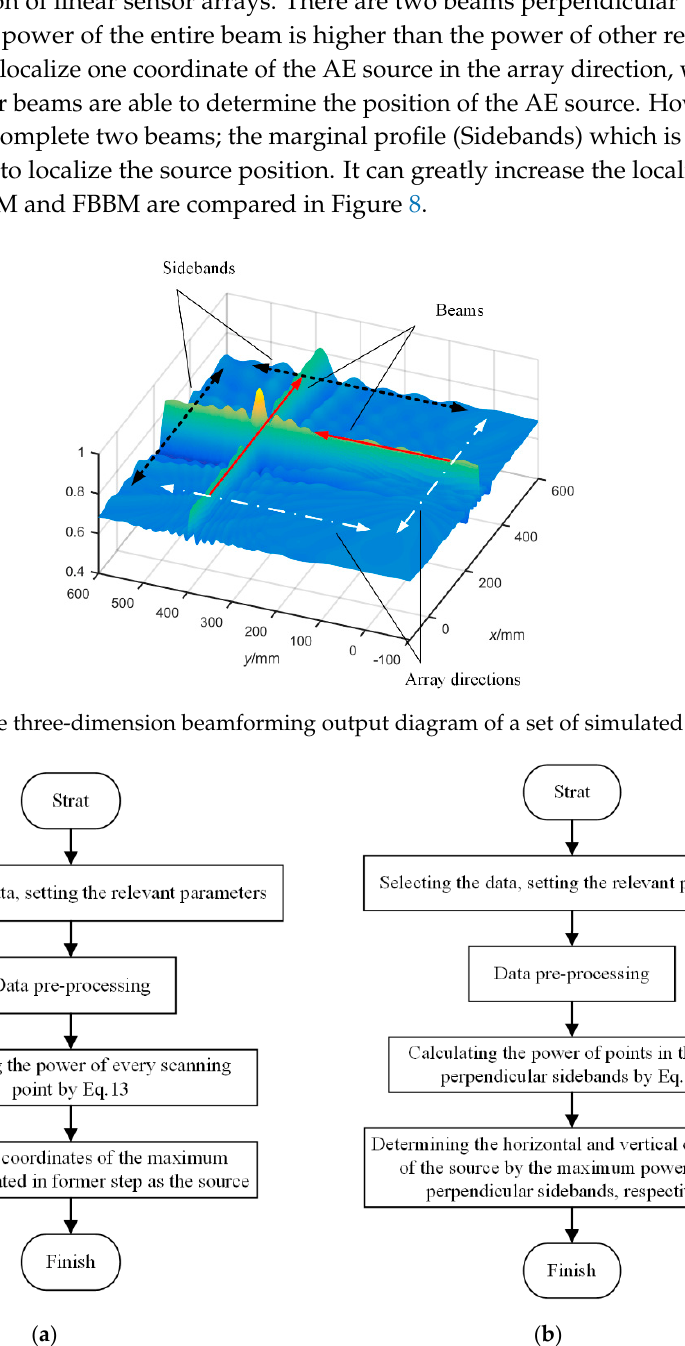
Figure 8. The flowcharts of the Bartlett beamforming method (BBM) and fast Bartlett beamforming